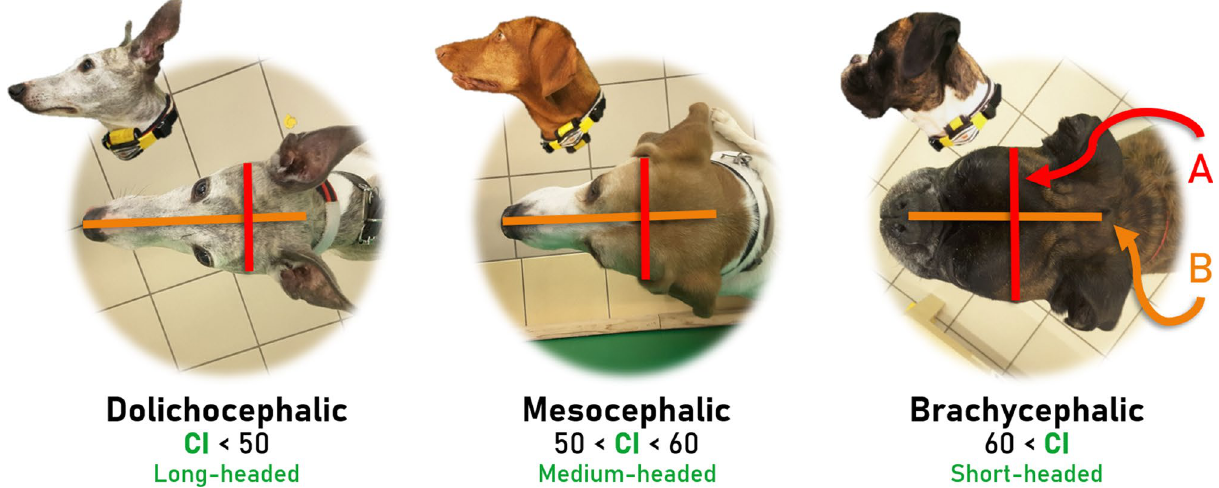
Figure 1. The typical classification of dogs’ head shape based on the cephalic index value. Cephalic index (CI) is the ratio of the maximum width of the head ( A ) multiplied by 100 divided by the head’s maximum length ( B ). The shorter a dog’s head is, the higher the cephalic